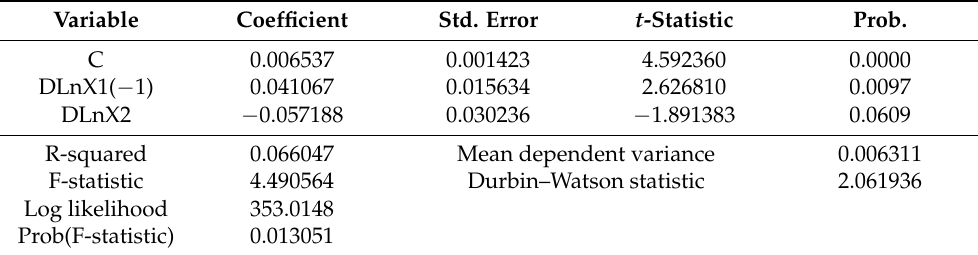
Table 4. Modified model: dependent variable: DLnY. Method: least squares. Sample: 2009M07